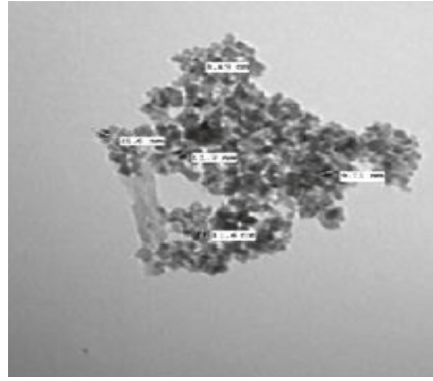
Figure 2: The TEM micrograph of Fe